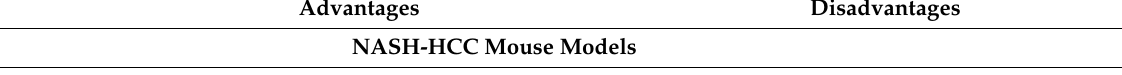
Table 1. Cont . Advantages Disadvantages NASH-HCC Mouse Models Genetic